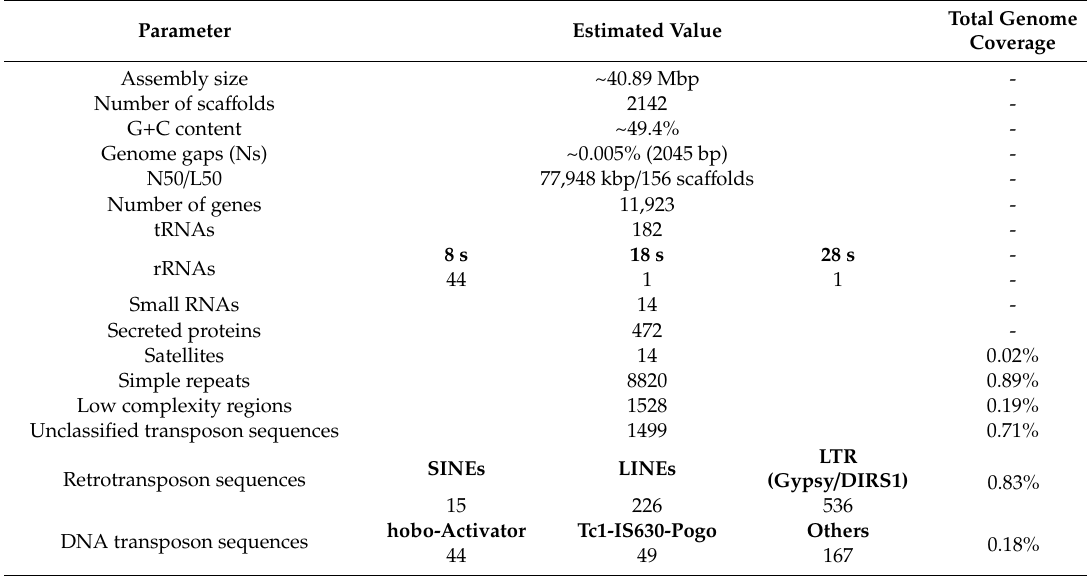
Table 1. Nuclear genome statistics: Parameters and content of the nuclear genome assembly of Trichoderma lixii